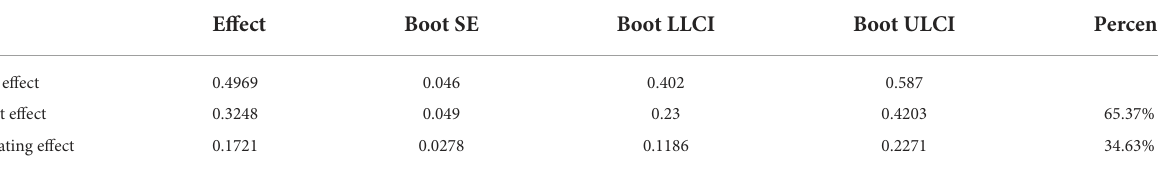
TABLE 9 Total, direct, and indirect